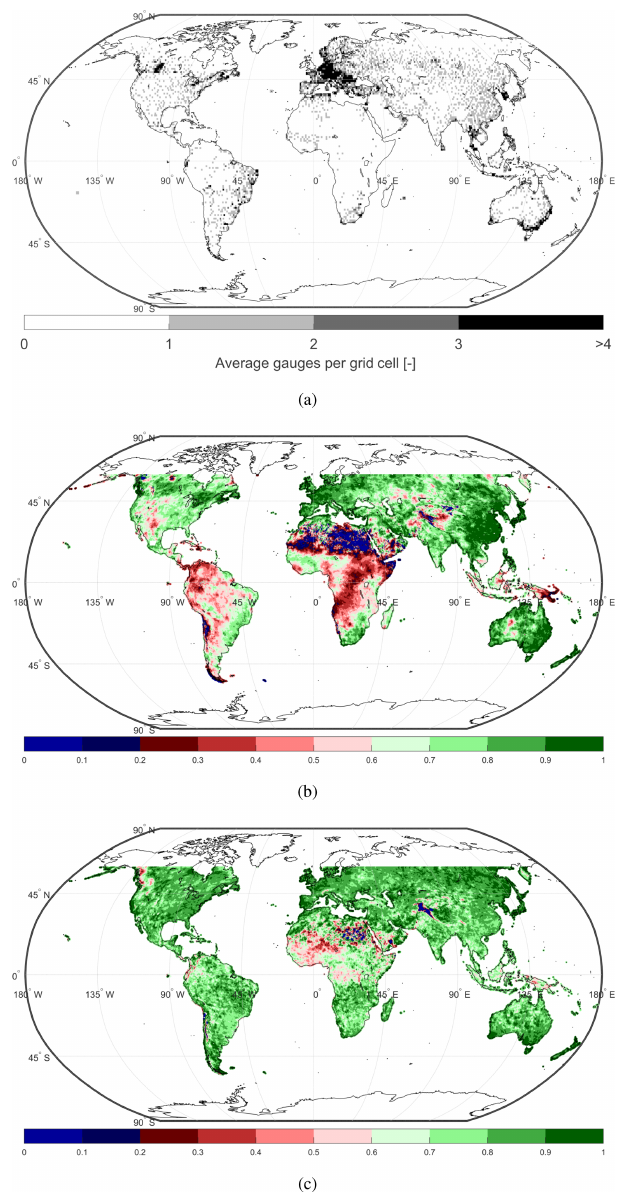
Figure 2. (a) Number of stations used for the GPCC First Guess 1.0 ◦ product for the years 2015–2018. (b) TC correlation of the GPCC First Guess 1.0 ◦ product in Africa during 2015–2018 using the triplet GPCC, ERA5 and SM2RAIN-ASCAT*. It can be seen that lower correlation areas closely match with areas of low station density. (c) TC correlation of the ERA5 reanalysis during 2015– 2018 for GPCC, ERA5 and